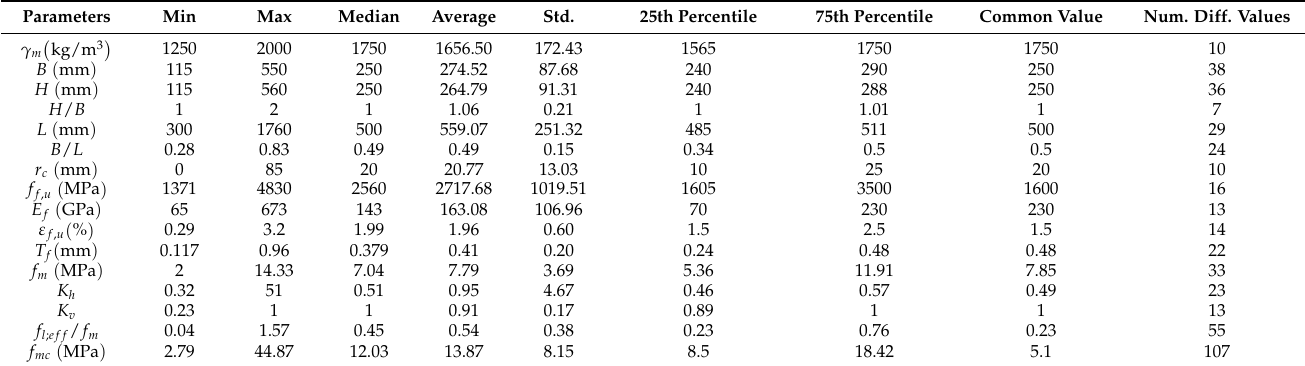
Table 2. Variation and statistical characteristics of main